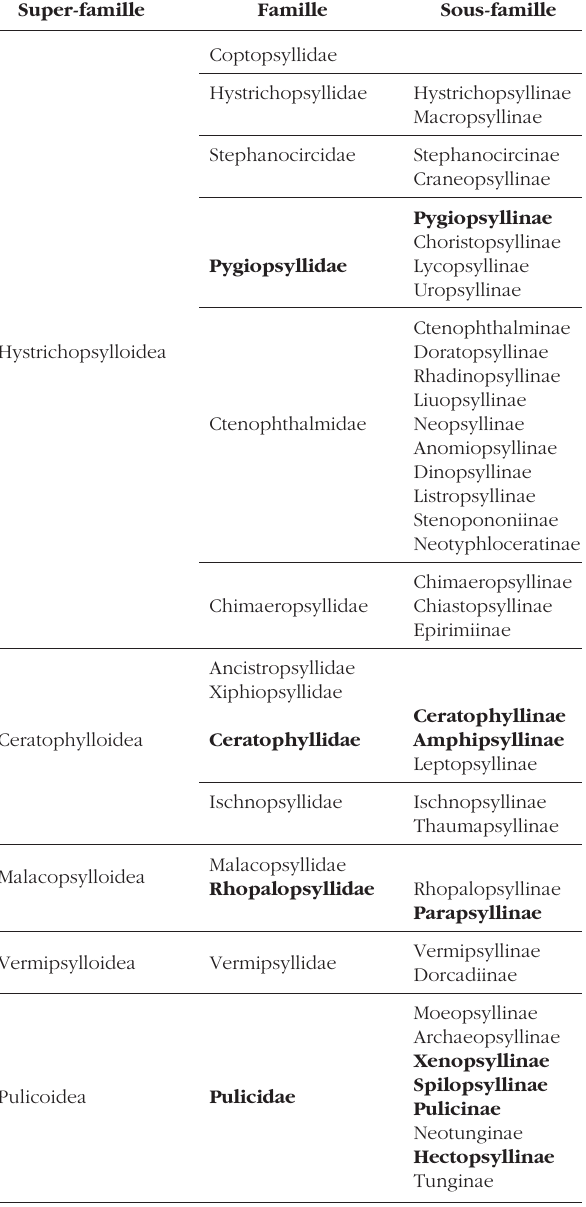
Tableau I. – Les Siphonaptères concernés par le parasitisme aviaire (Familles et sous Familles sont en caractères gras), d’après Smit,